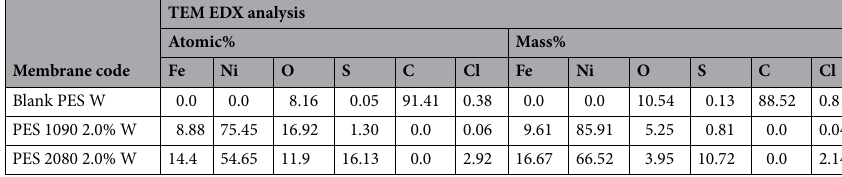
Table 3. EDX analysis of the fabricated membranes using TEM